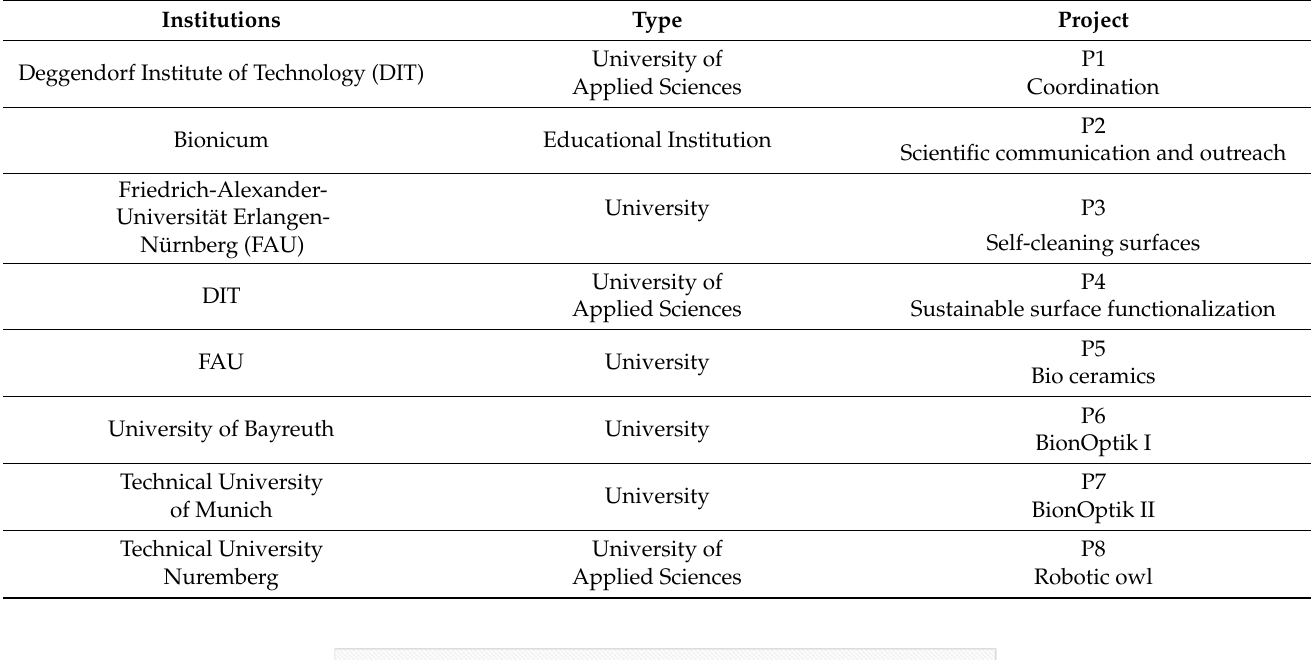
Table 1. Institutions participating in BayBionik.